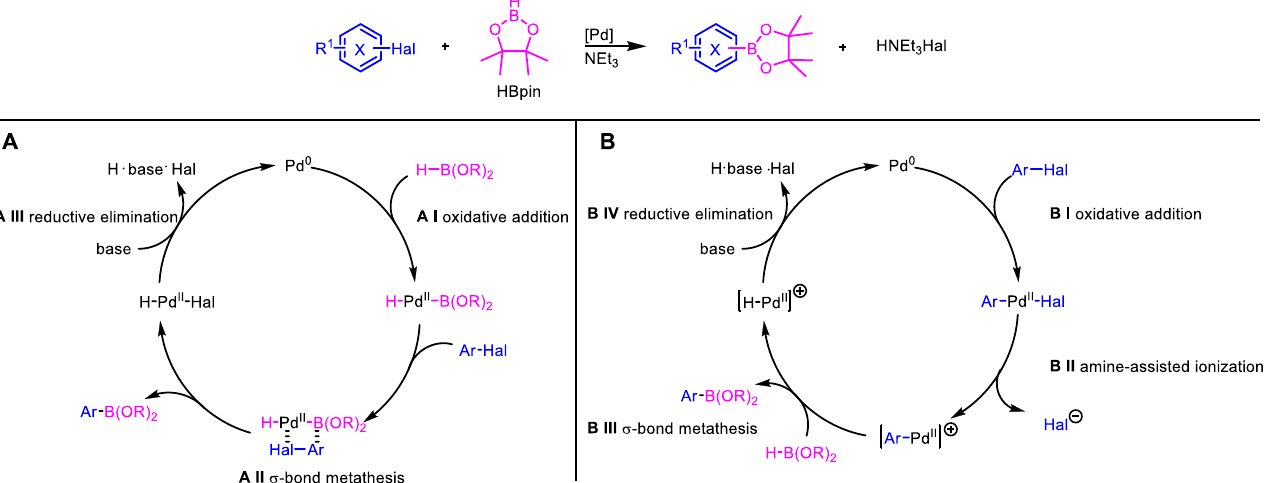
Figure 2. General scheme and proposed mechanisms by Masuda ( A ) and Lin ( B ) of a Masuda borylation.